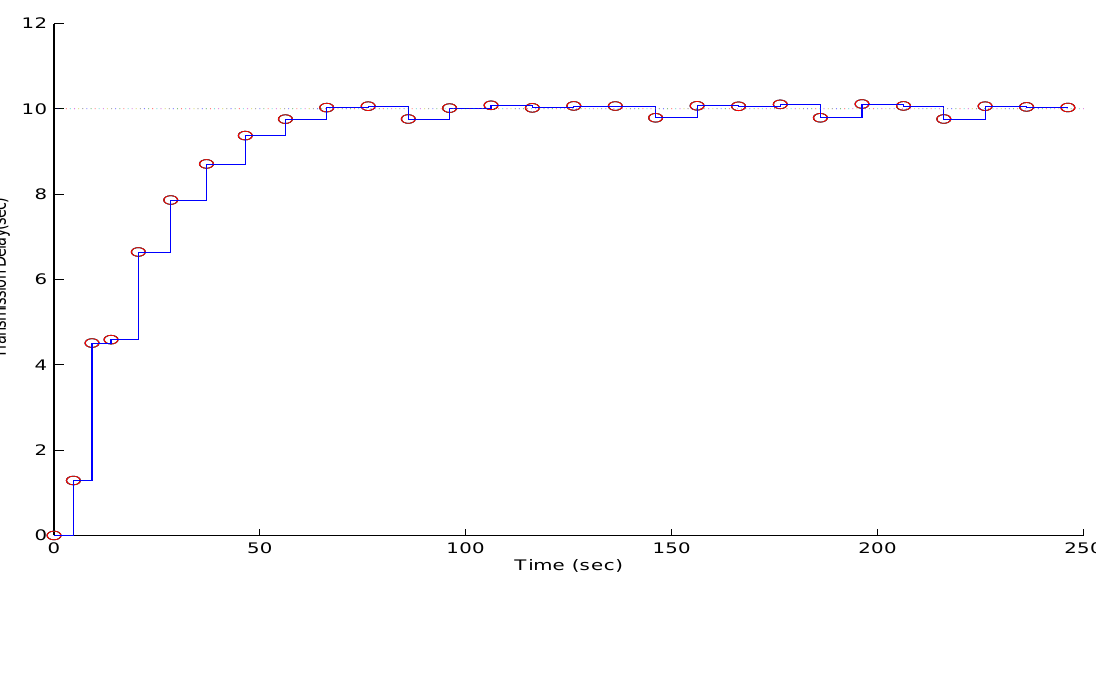
Figure 7 . Measured Time Delay for transmitting an image frame over experimental time (Initial values R = 0 : 3 , T d = 10 s, and (cid:22) = 0 : 01